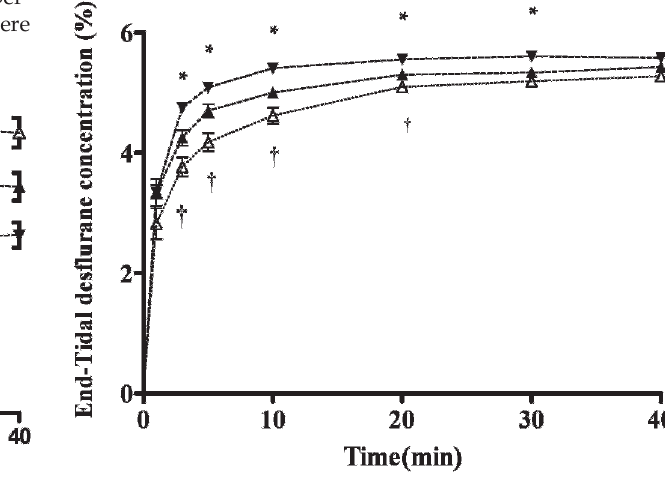
Figure 3 - End-tidal desflurane concentration (CEdes) time curves under three different ventilatory states, including hyperventila- tion (-- . --), normal ventilation (-- m --), and hypoventilation (-- g --), during 40 minutes of study. Data are presented as the mean ¡ standard deviation.Statistically significant differences are shown by * p , 0.05 for hyperventilation vs . normal ventilation, and { p , 0.05 for hypoventilation vs. normal